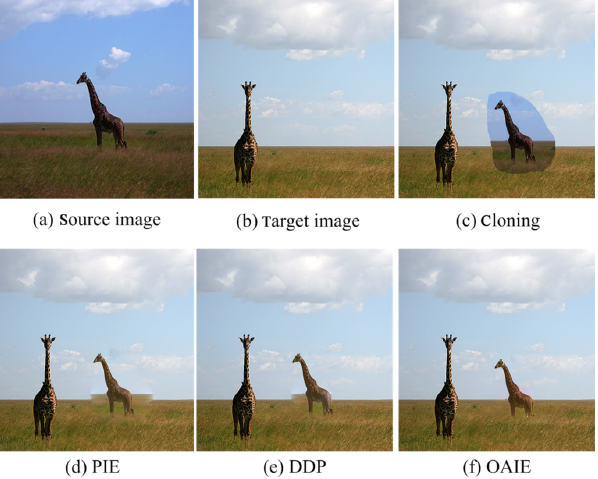
Fig. 8 Limitations of our method and other methods. Color bleeding exists in our result, while the results from PIE and DDP have serious structure artifacts.